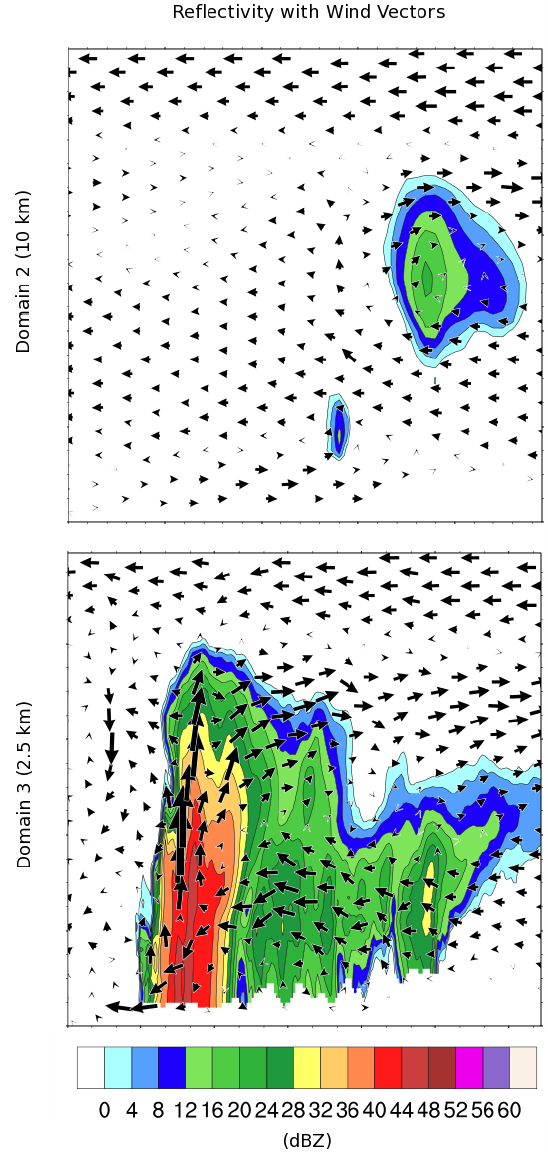
Figure 8. Cross-sections of WRF model simulated radar reflectivity (dBZ) on domains 2 and 3 at 0300 UTC 14 July ( top and bottom panels, respectively). Wind vectors on radar reflectivity panel are scaled such that the horizontal wind is ten times larger than the vertical wind. The vertical planes to construct the cross section are defined intersecting a point at 29.69° N and 111.4° W and extending along constant latitude from 112.5° W to 107.5° W, and the frames have a height of about 20 km. They are averages of parallel planes north and south of the center and extend through the depth of the model. Figure from [25], submitted manuscript.